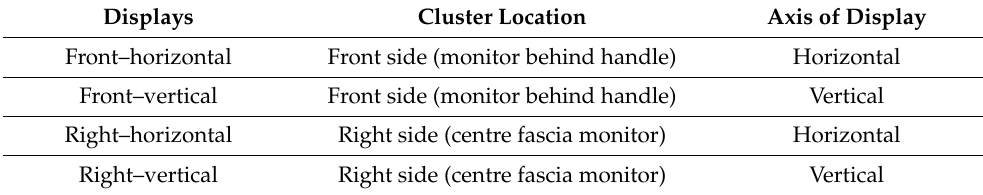
Table 1. Four types of displays and their